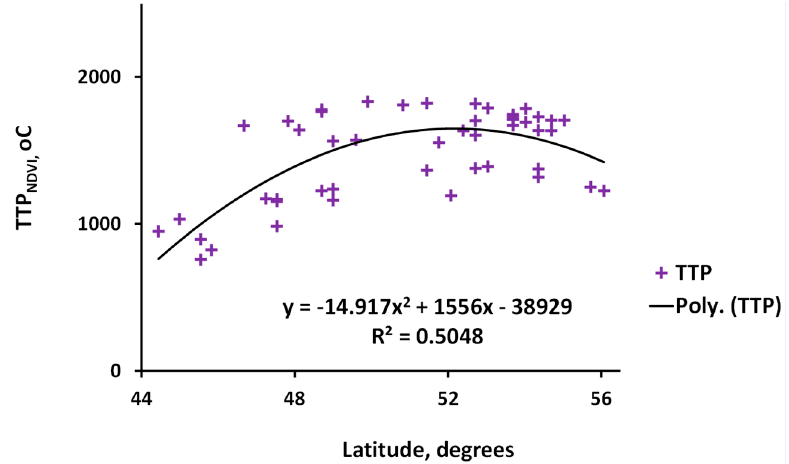
Figure 7. Scatterplot for TTP NDVI as a function of latitude fitted with a convex quadratic model. There is a significant positive relationship (R 2 = 0.50): as latitude increased, TTP NDVI increased in lower latitudes to certain limit and then declined in the northernmost study sites (54–56°N latitude).